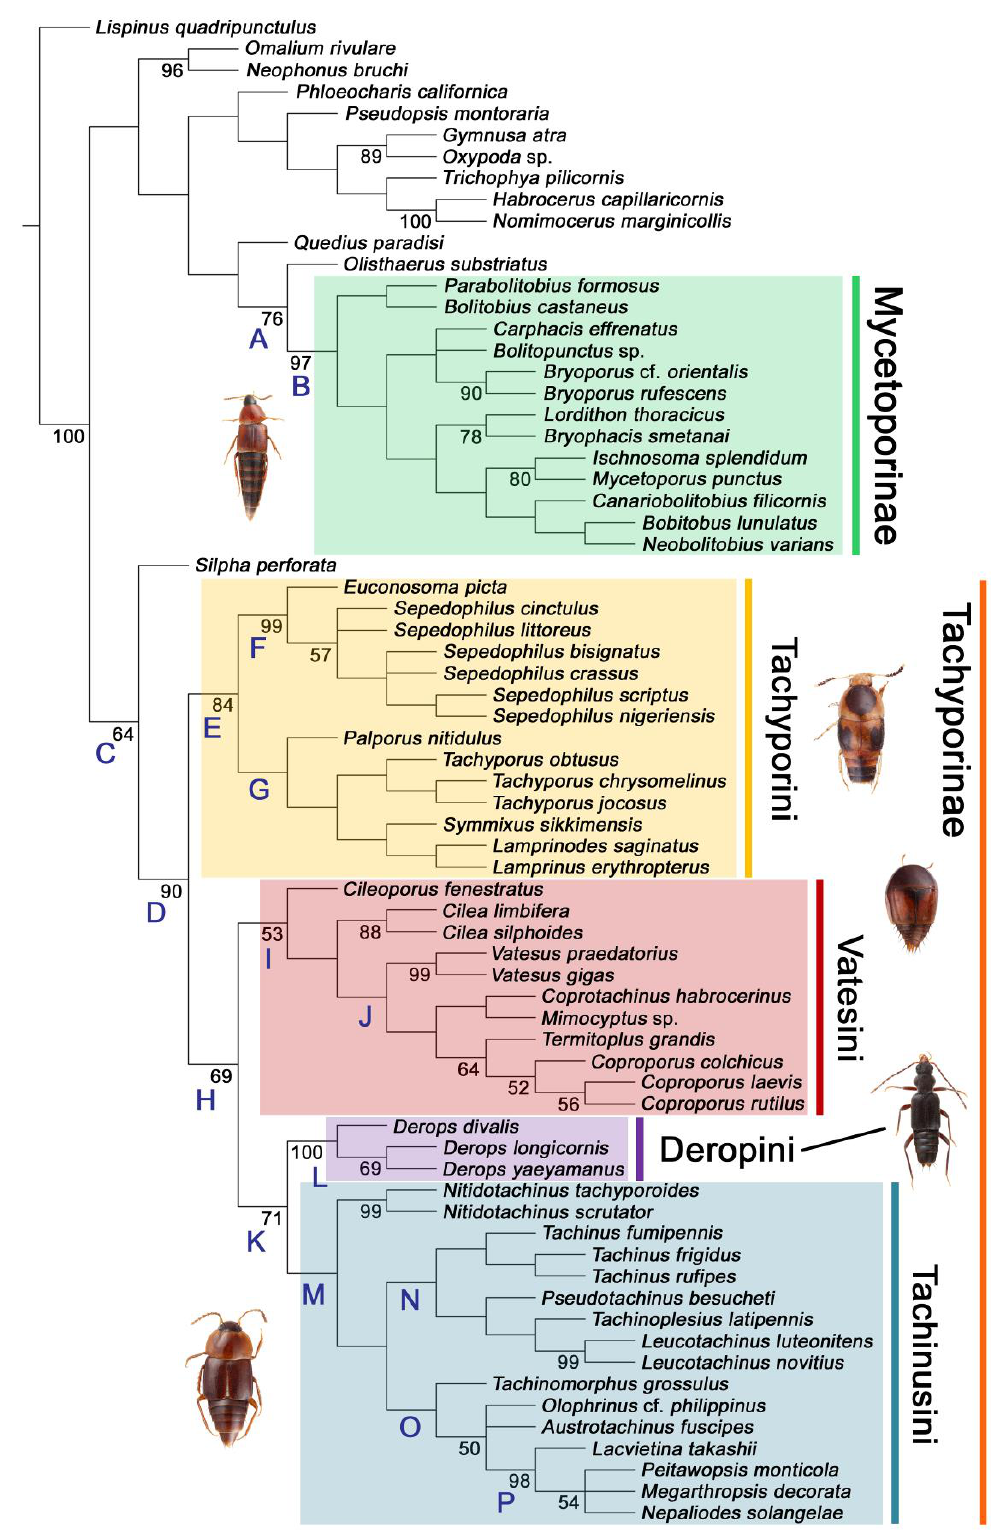
Figure 3. Results of the parsimony analysis of the phylogenetic relationships within Tachyporinae (strict consensus tree of the three obtained trees), refleccting my revised classification of Tachyporinae and its tribes. Each taxon name shown here reflects my taxonomic changes. A series of clades are named and used in the main text. Bootstrap support values > 50 are shown below